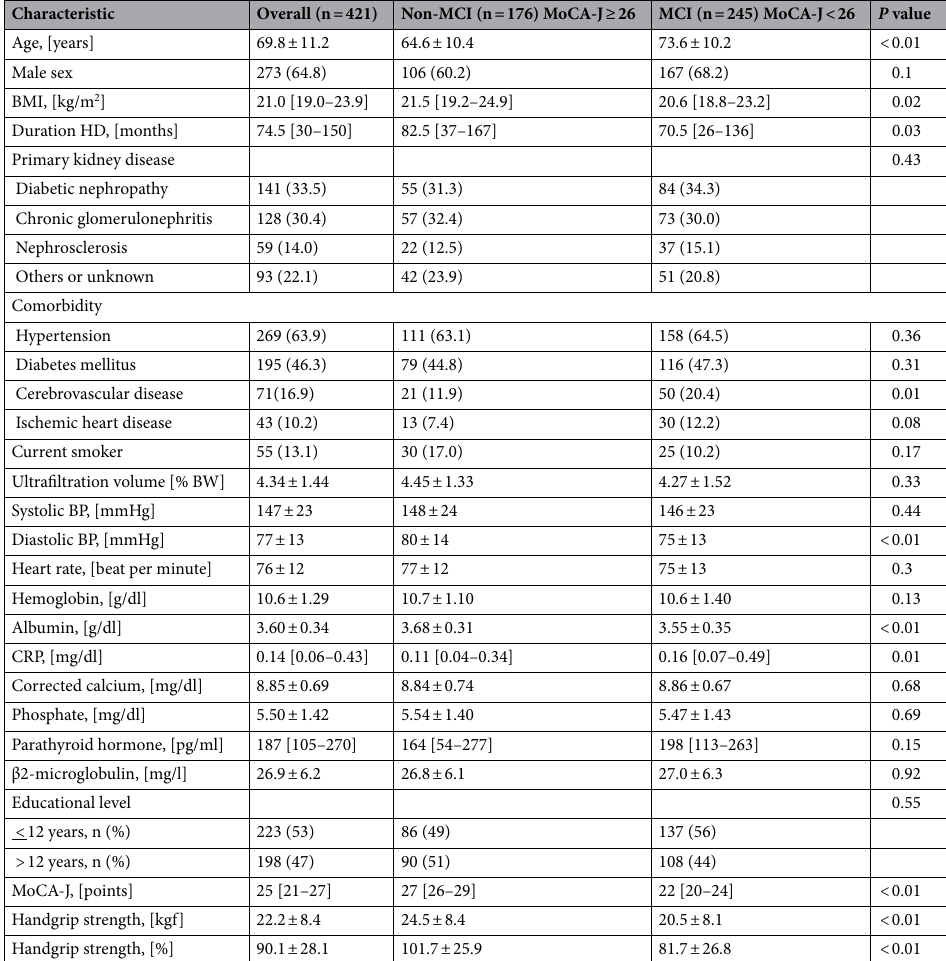
Table 1. Patient characteristics. Values for categorical variables are presented as count (percentage); values for continuous variables are presented as mean ± standard deviation or median (interquartile range). The non- MCI group included 176 patients with normal cognitive function, defined as a MoCA-J score ≥ 26. The MCI group included 245 patients with mild cognitive impairment, defined as a MoCA-J score < 26. Percent handgrip strength was calculated as follows: [males] handgrip strength [kg] × 100/28; [females] handgrip strength [kg] × 100/18. Unpaired t-tests , Mann–Whitney U- tests, and c 2 tests were used to evaluate differences. MCI mild cognitive impairment, MoCA-J Japanese version of the Montreal Cognitive Assessment, BMI body mass index, HD hemodialysis, BW body weight, BP blood pressure, CRP C-reactive